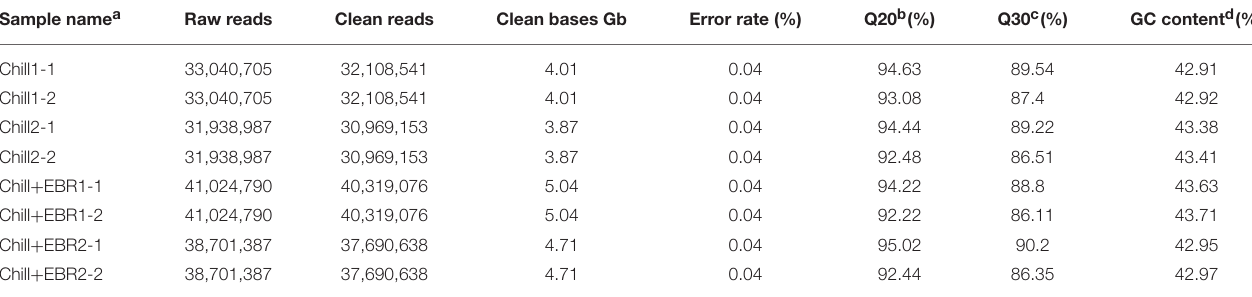
TABLE 1 | Summary of sequence assembly after illumina